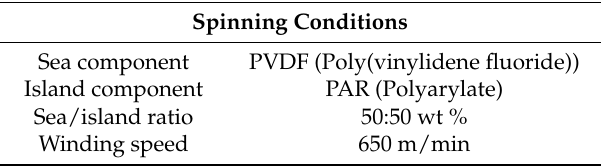
Figure 1. Schematics of the conjugate spinning process for the preparation of PVDF/PAR island-in-a- sea fiber. Table 1. Spinning conditions of PVDF/PAR island-in-a-sea